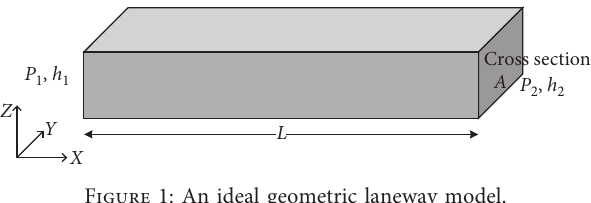
Figure 1: An ideal geometric laneway